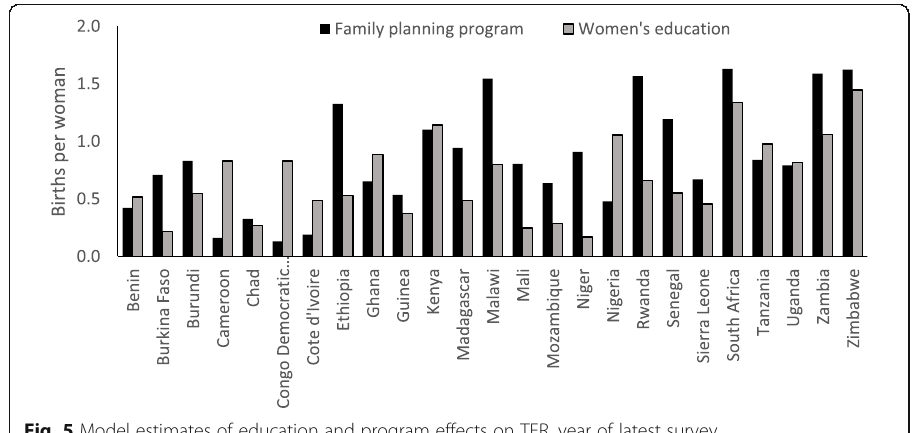
Fig. 5 Model estimates of education and program effects on TFR, year of latest